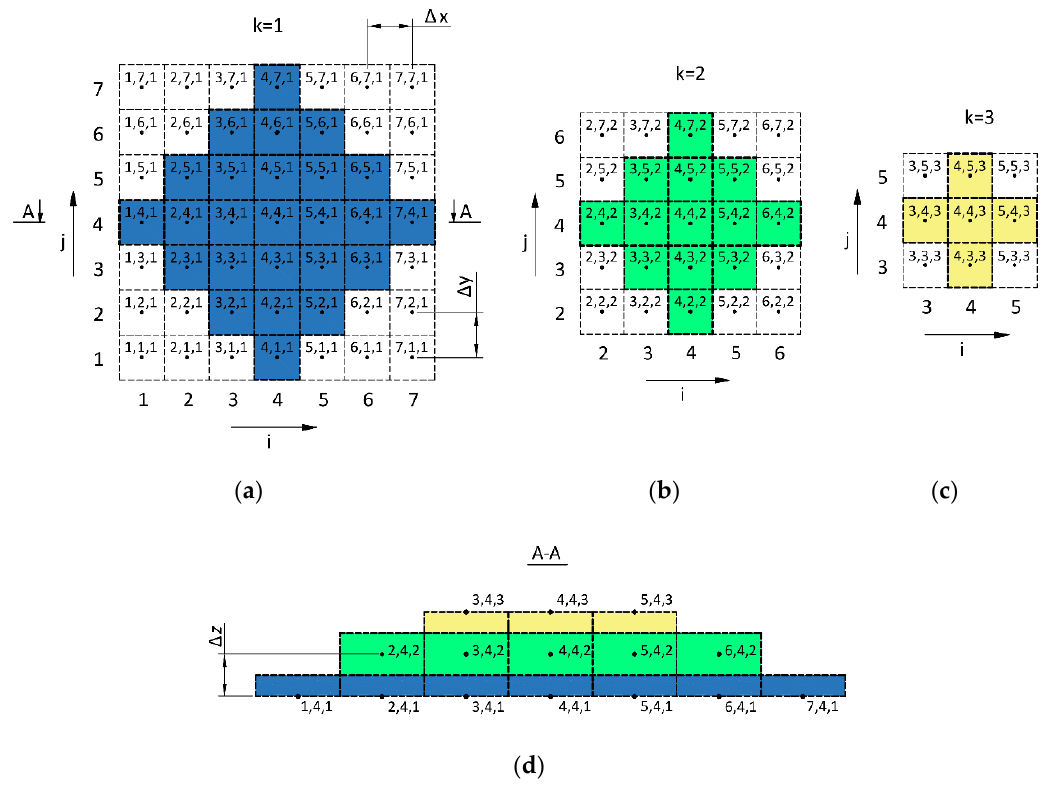
Figure 3. View of the planes on which the nodes of the control volume are located: ( a ) external insulated surface with marked points at which temperature is measured; ( b ) surface z = Δ z ; ( c ) exposed slab surface z = 2 ∆ z ; ( d ) cross-section through the center of the slab with marked nodes.